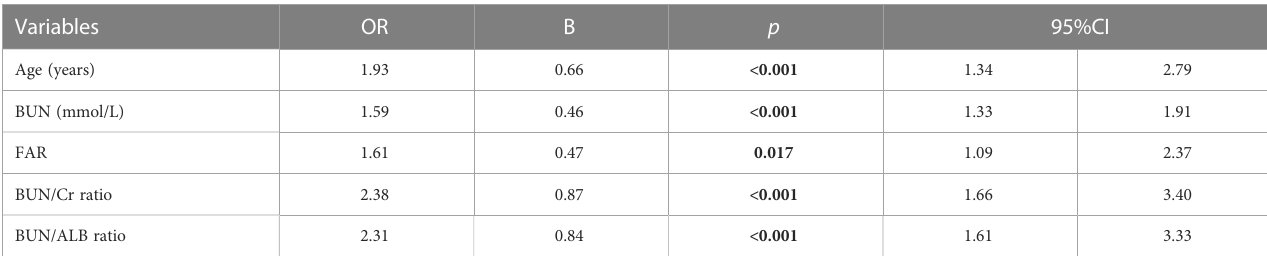
TABLE 3 Multivariable logistic model of probability of GDM in training dataset. Variables